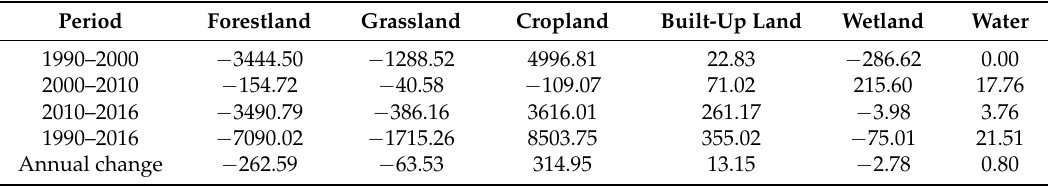
Figure 8. ( a ) Land cover/use dynamics, and ( b ) major land cover/use conversions in Rwanda (1990–2016). Table 4. Land cover/use changes (Km 2 ) in Rwanda